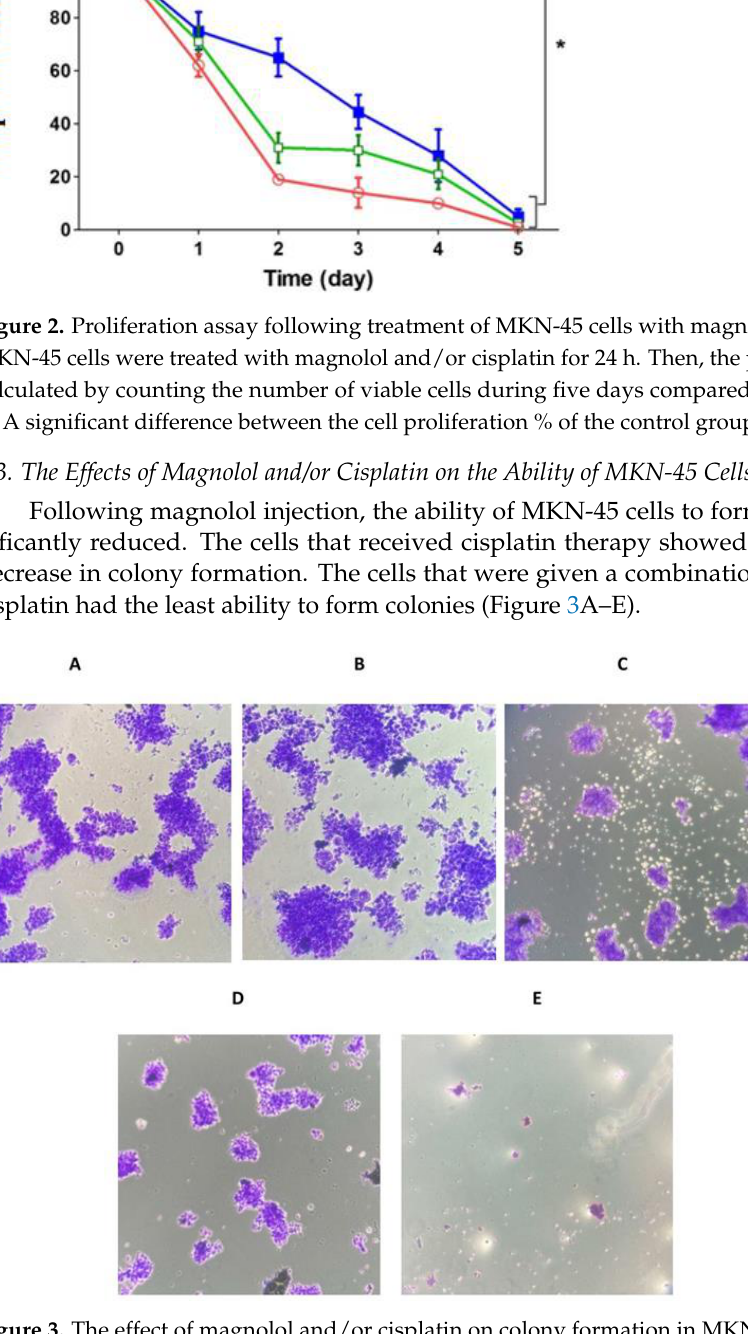
Figure 3. The effect of magnolol and/or cisplatin on colony formation in MKN-45 cells. ( A ) control group 1 (no treatment), ( B ) control group 2 (treated with PBS), ( C ) treated with magnolol, ( D ) treated with cisplatin, ( E ) treated with magnolol and cisplatin.